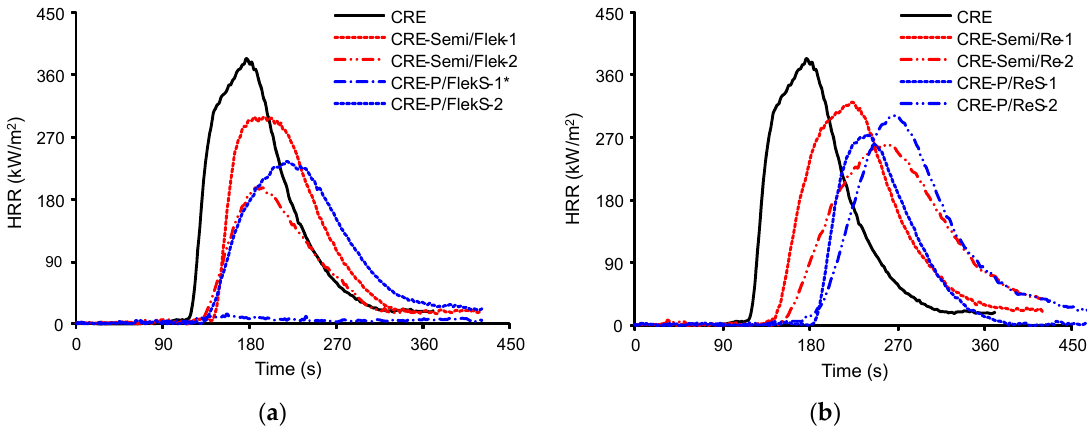
Figure 4. Heat release rate (HRR) versus time curves of the control and coated samples with ( a ) Flekashield and ( b ) Recoxit particles at 50 kW / m 2 heat flux.